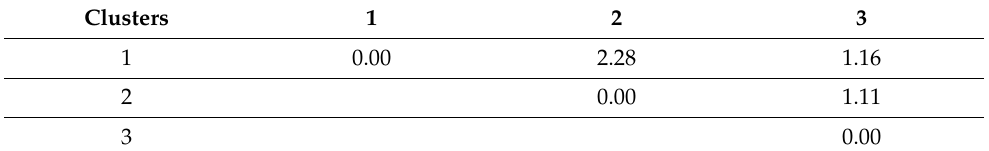
Table 5. Euclidean distance between clusters obtained by the k-means method for TOC, Nt and C/N. Clusters